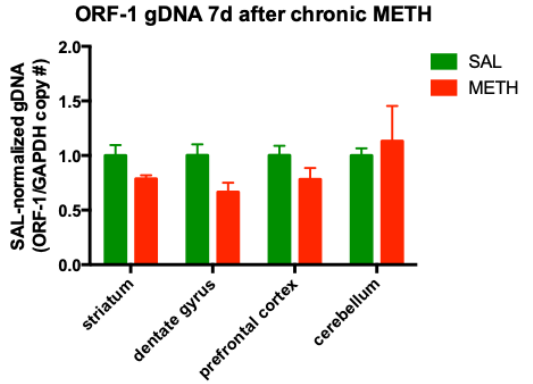
Figure 5. The effect of chronic METH (20 mg/kg/d, for 10 d, i.p.) on ORF-1 copy number within the genomic DNA (gDNA) in rat striatum, dentate gyrus, prefrontal cortex and cerebellum, at 7 d after the last dose of METH or saline. Abbreviations: d, day; METH, methamphetamine; SAL, saline.